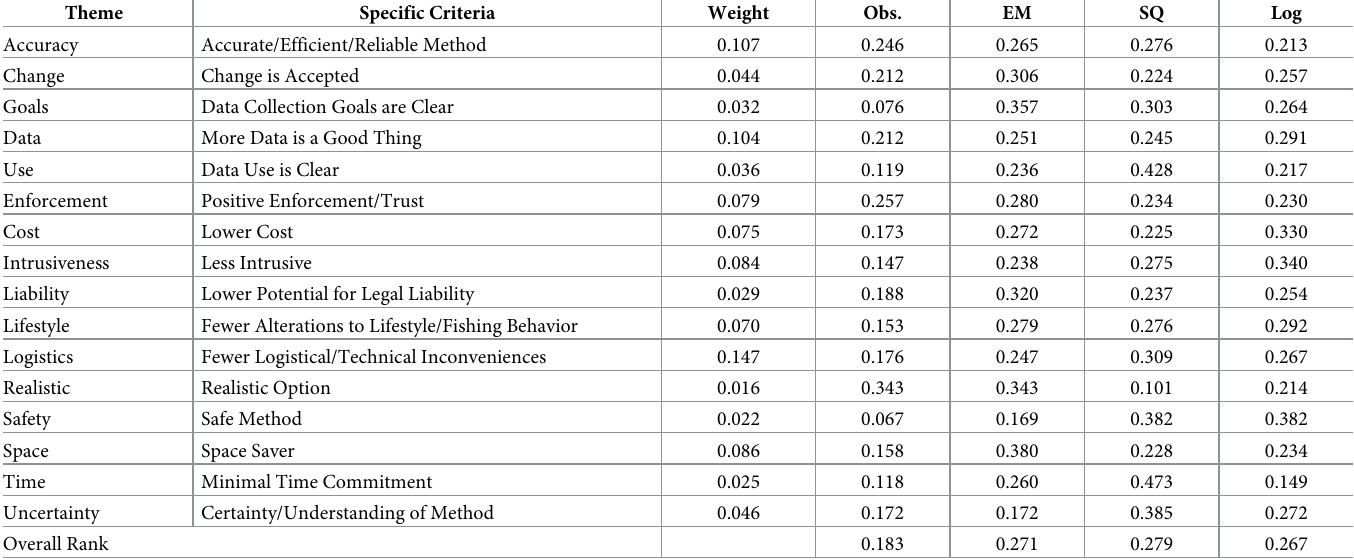
Table 6. Weighted criteria and overall rank of human observers (‘Obs.’), electronic monitoring (‘EM’), detailed logbooks (‘Log’), and the status quo (‘SQ’) alterna- tives for data collection at sea across 16